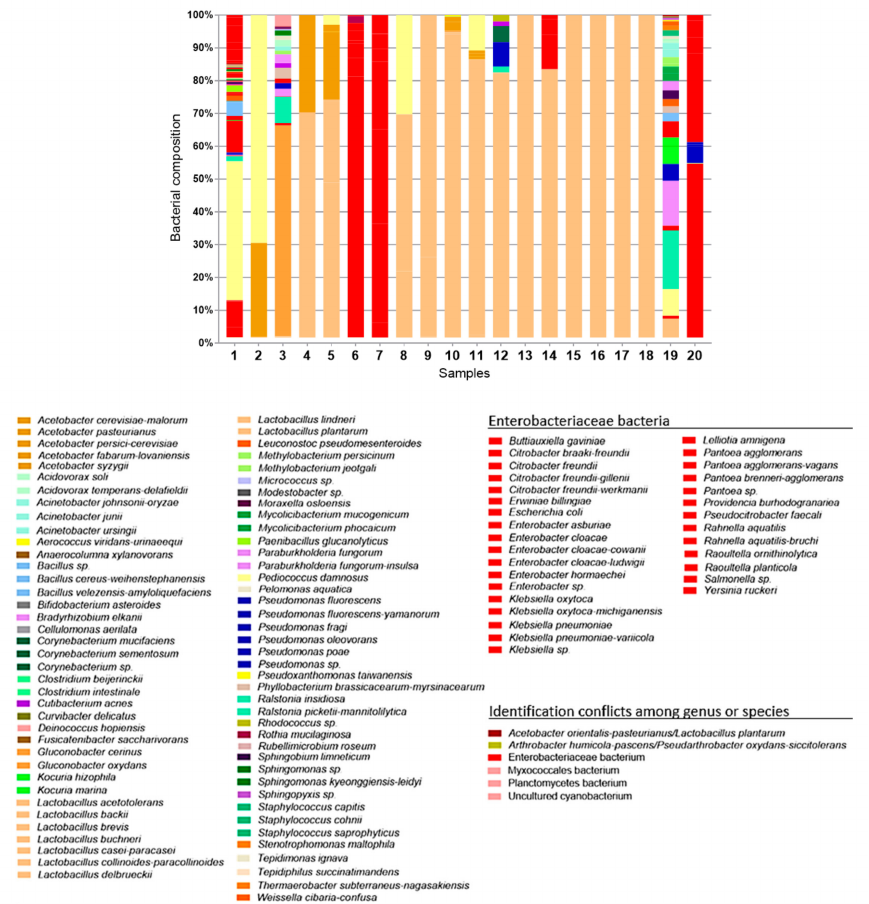
Figure 1. Bacterial composition of the 20 samples analyzed. Bacterial identification was performed from ASVs originating from NGS using the V3/V4 region of the 16S rRNA gene. Due to the large number of species found, colors for identification were designated according to genera, with the exception of the Enterobacteriaceae family which is identified in the graph with the red color